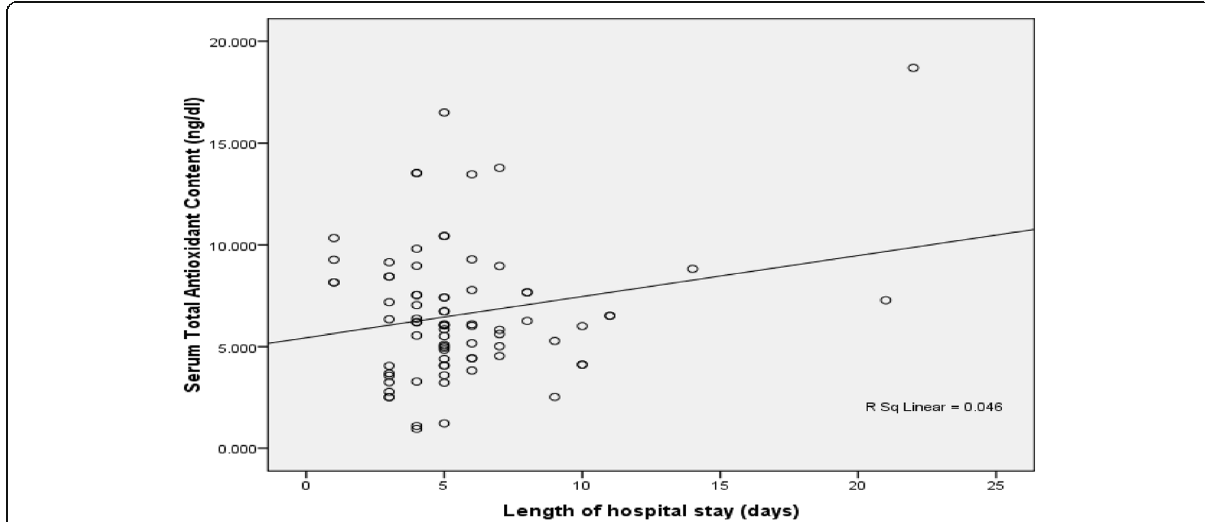
Fig. 4 Scattered plot of serum TAC and length of hospital